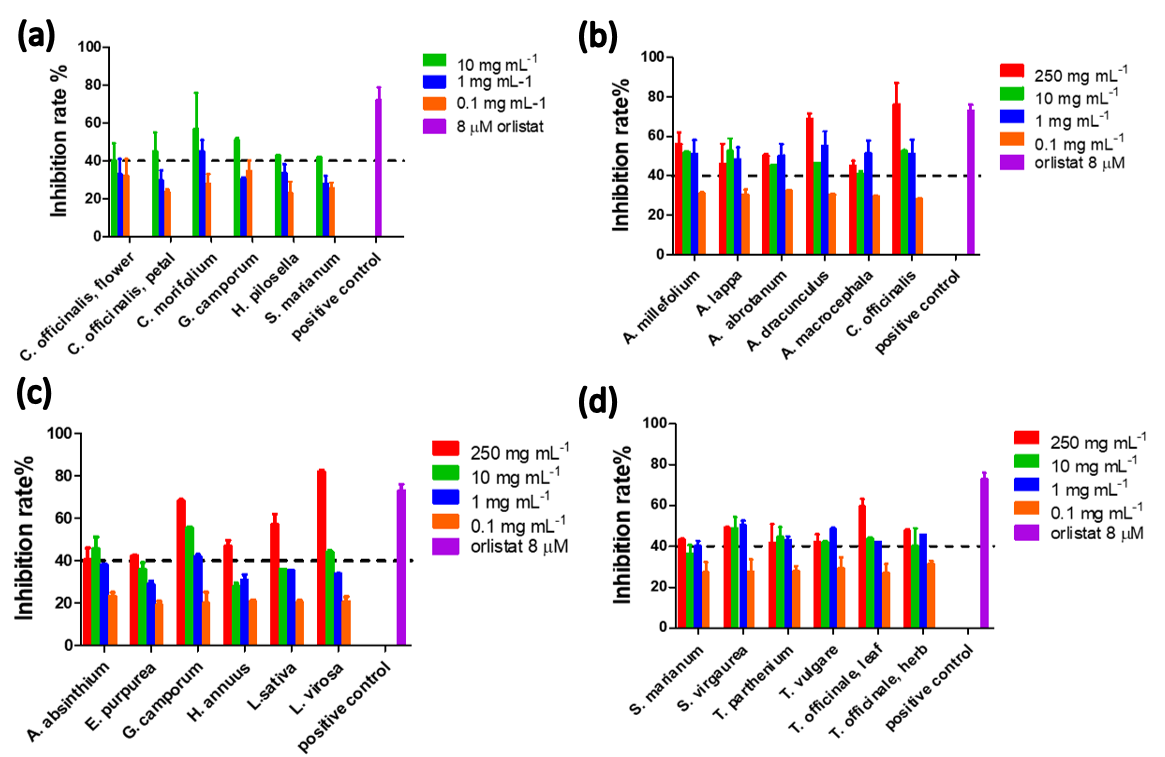
Figure 3. Monitored inhibitory effect on PNLIP activity induced by serial dilutions of the selected Asteraceae plant extracts. ( a ) Aqueous and ( b – d ) DCM extracts of the Asteraceae plants exceeding the 40% cut-off inhibition rate.